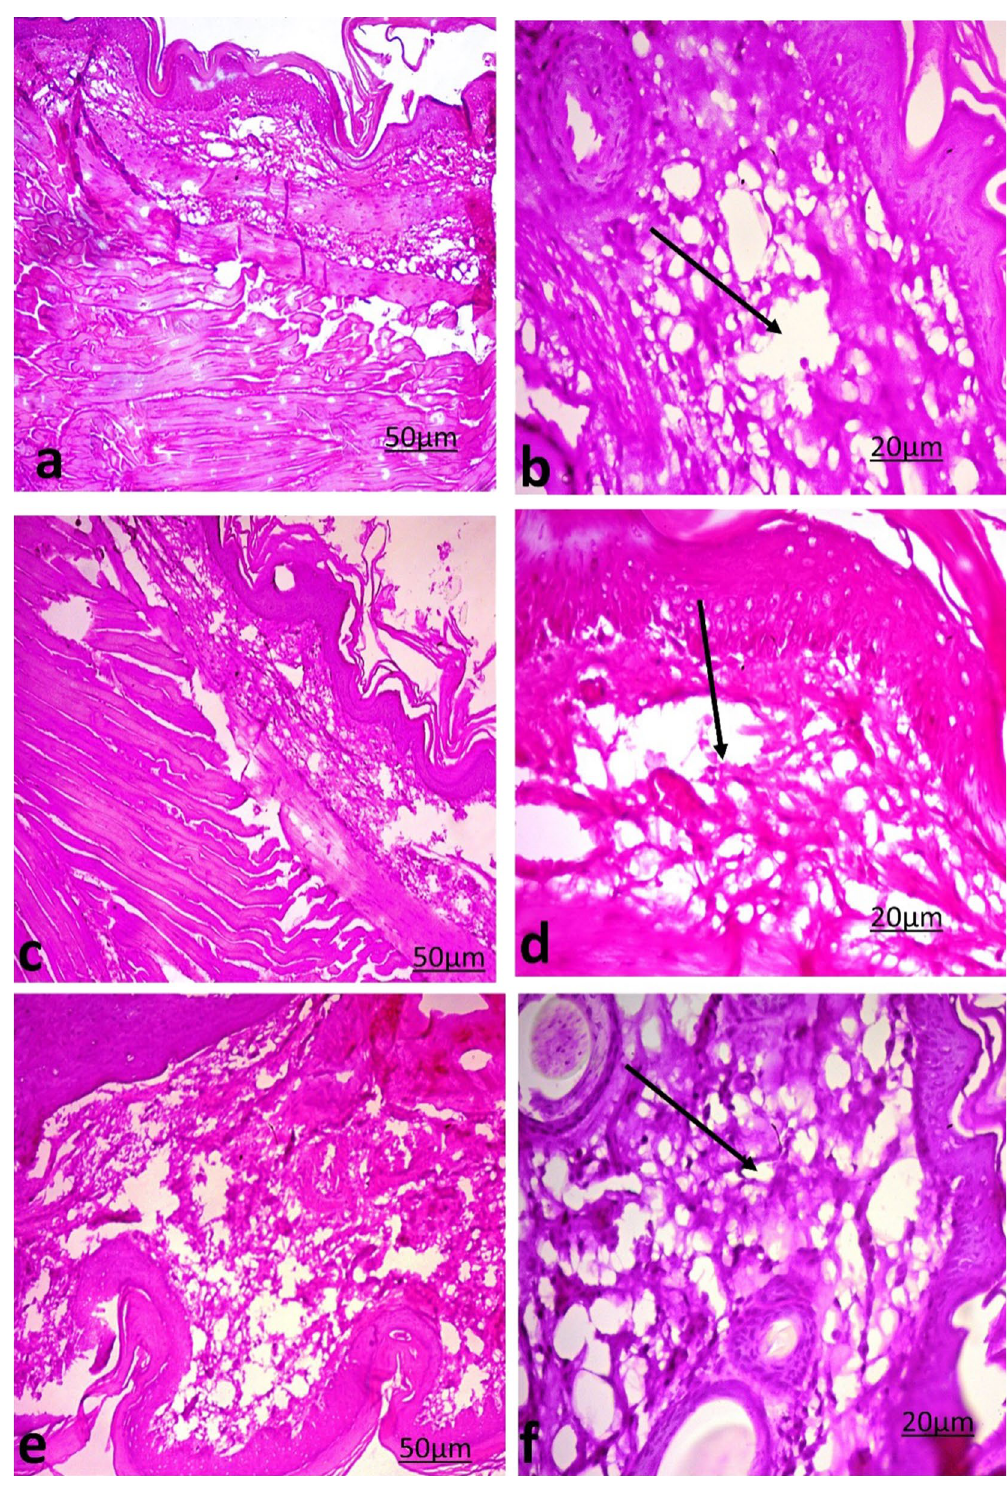
Figure 5. Representative photographs from footpad biopsies of PHA-injected model animals showing the effect of Nigella sativa seeds against PHA-induced inflammation in rats. Control rats ( a & b ), rats fed 30 mg of Nigella sativa seeds in the diet for 30 days ( b & c ), rats fed 50 mg of Nigella sativa seeds in the diet for 30 days ( c & d ). → : lymphocytic infiltration and edema in the dermis (H&E stain, ×100 and ×200